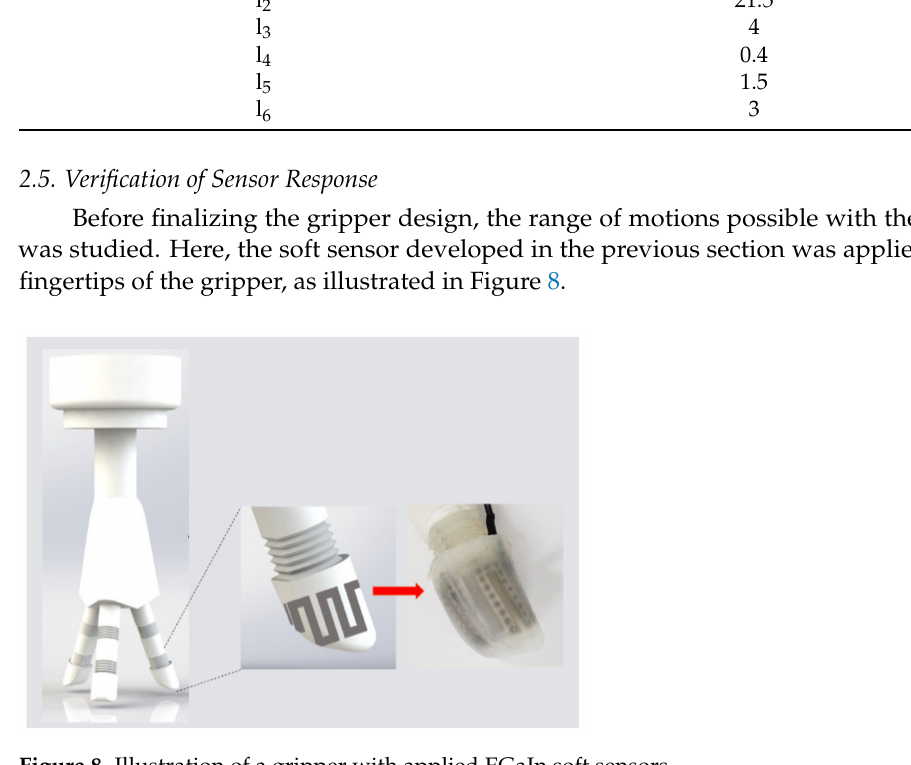
Figure 8. Illustration of a gripper with applied EGaIn soft